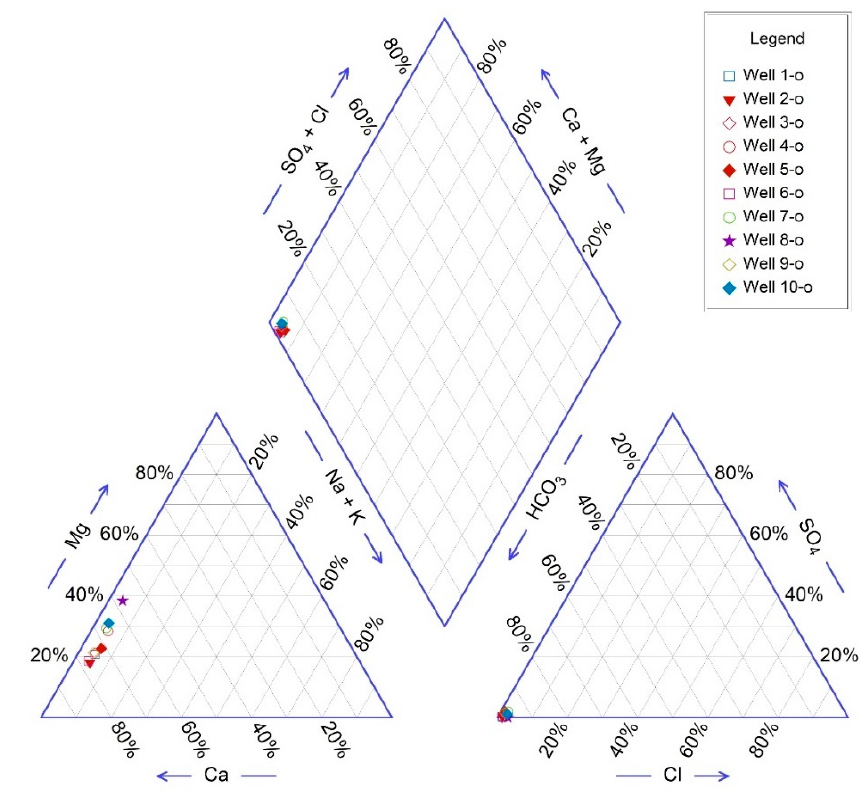
Figure 2. Piper diagram of test site groundwater chemical composition.